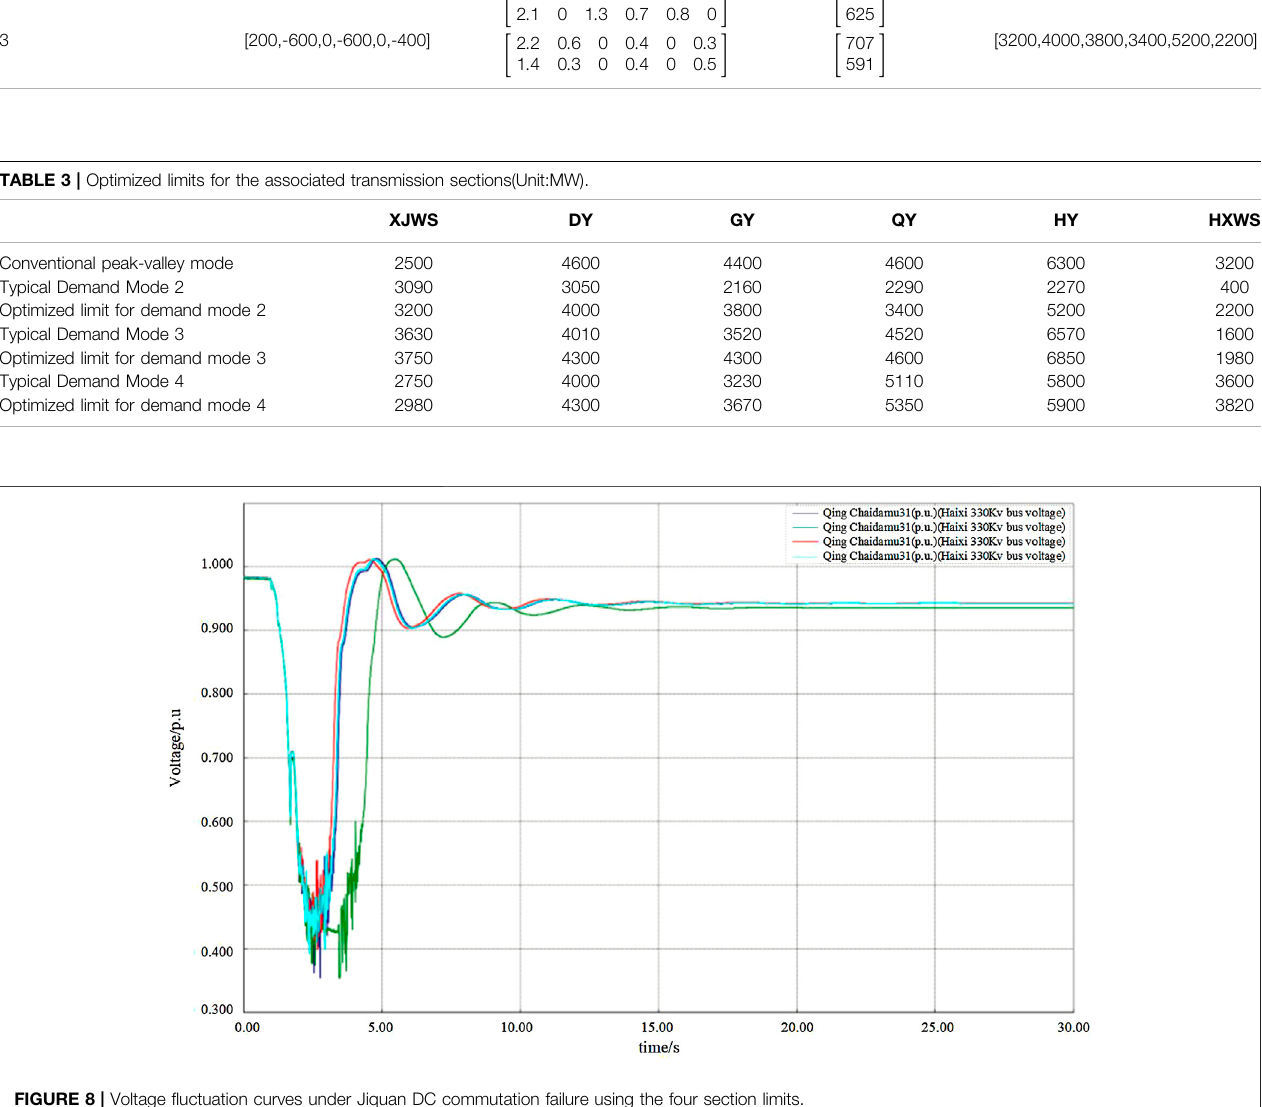
FIGURE 8 | Voltage fl uctuation curves under Jiquan DC commutation failure using the four section limits.